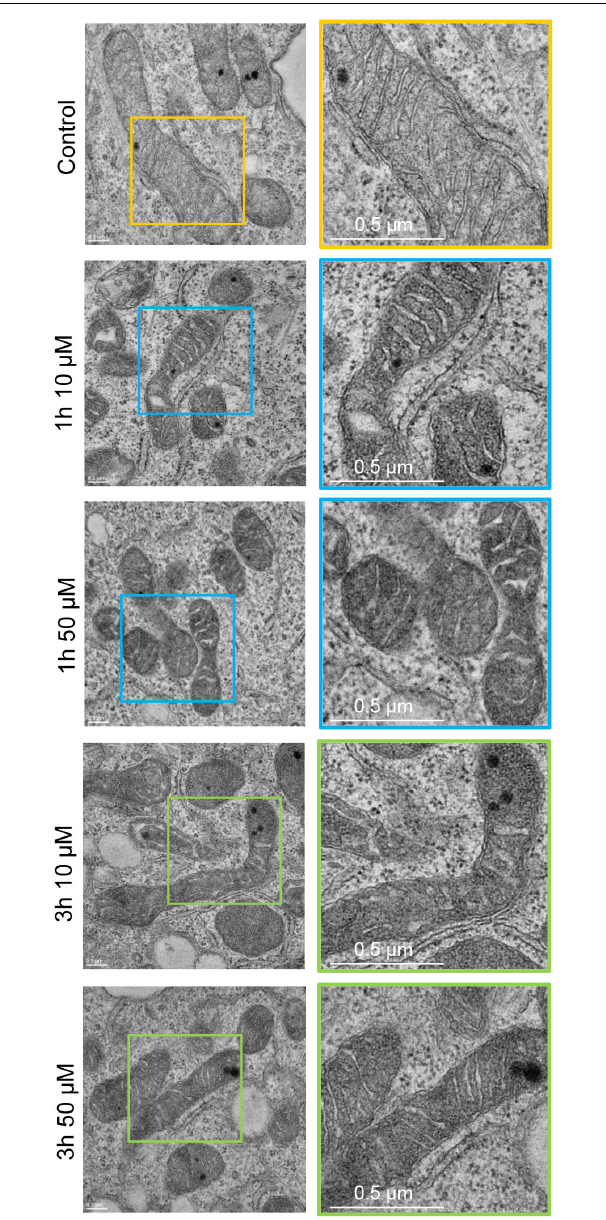
FIGURE 4 | Visualization of mitochondria and their ultrastructure in 3O-C 12 -HSL-treated epithelial Caco-2 cells. Cells were either treated with 0.02% DMSO as a diluent (Control), or 10 and 50 µ M 3O-C 12 -HSL for 1 or 3 h. Cells were fixed, stained with uranyl acetate and analyzed by TEM. The data are from one of three independent experiments. Left panel, bar: 0.2 µ m. Right panel, bar: 0.5 µ m. Size of zoomed inserts with colored boards in the right panel is approximately 1 µ m × 1 µ m.